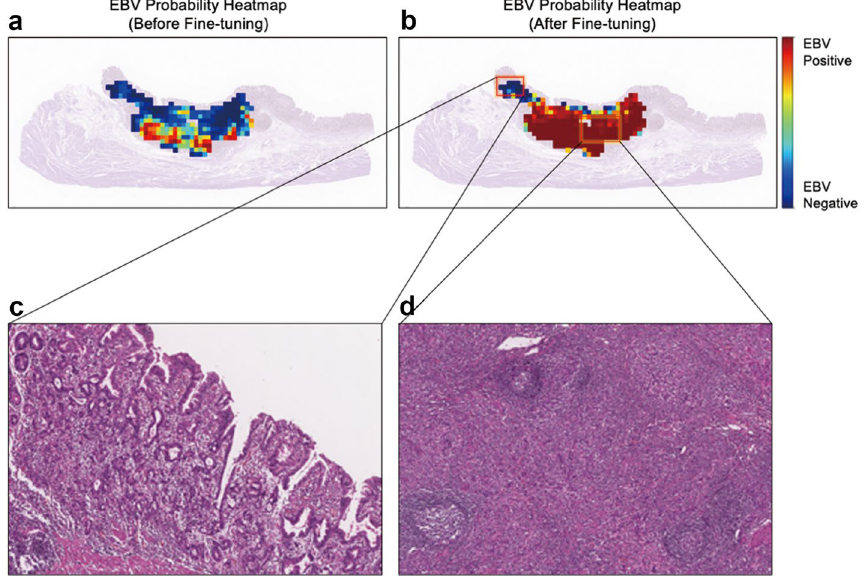
Figure 4. Representative heatmaps of an EBV positive case. The colors of the overlaid heatmaps represent the output of the EBV classification model (second classifier in the sequential classification framework), which means predicted probabilities of being an EBV-positive tumor, as defined in the color bar. In the top row, each heatmap corresponds to the EBV positive tumor probability values from classifiers before ( a ) and after ( b ) fine- tuning with the ISH dataset. A zoomed-in view of a region with low probability ( c ) and high probability ( d ) of being an EBV positive tumor, according to the fine-tuned EBV classifier (EBVNet), is visualized in the bottom